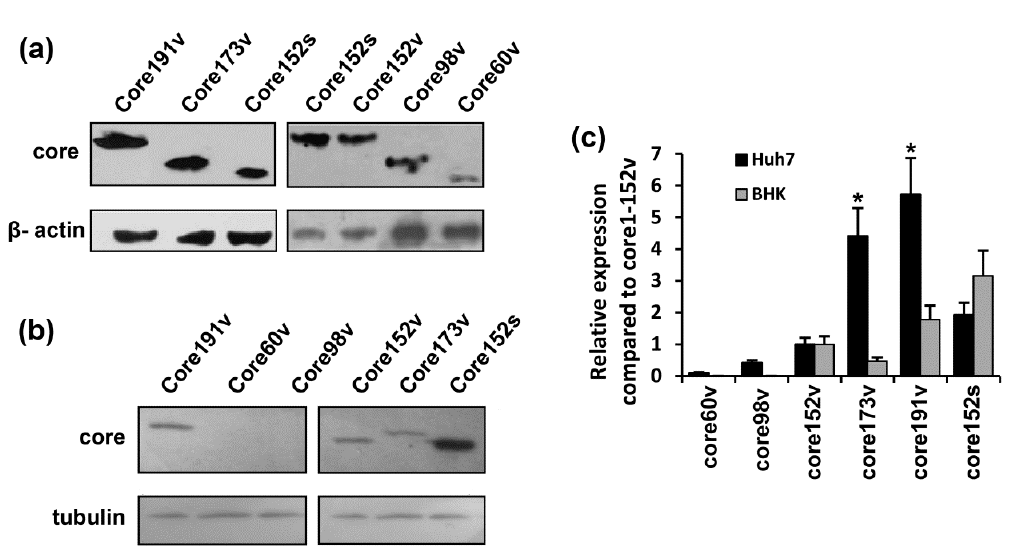
Figure 2. Eukaryotic expression of the full-length and truncated variants of HCV core protein. HCV core coding plasmids were used to transfect Huh-7 ( a ) or BHK-21 cells ( b ). In brief, 48 h post transfection, the cells were lysed, resolved by SDS-PAGE and subjected to Western blotting with anti-core rabbit antibodies [60] ( a , b , upper panels). After core-specific staining, the blots were stripped and re-stained with antibodies to tubulin or β -actin ( a , b , lower panels). ( c ) The signals generated in each experiment were quantified using ImageJ, core-specific signals were normalized to that of actin for Huh7, or tubulin for BHK-21 cells, and presented as fold-difference to the level of expression of core151v (altogether four separate experiments). Core173v and 191v were better expressed in Huh7 cells (* p < 0.05); levels of expression of core152s in these two cell lines did not differ.